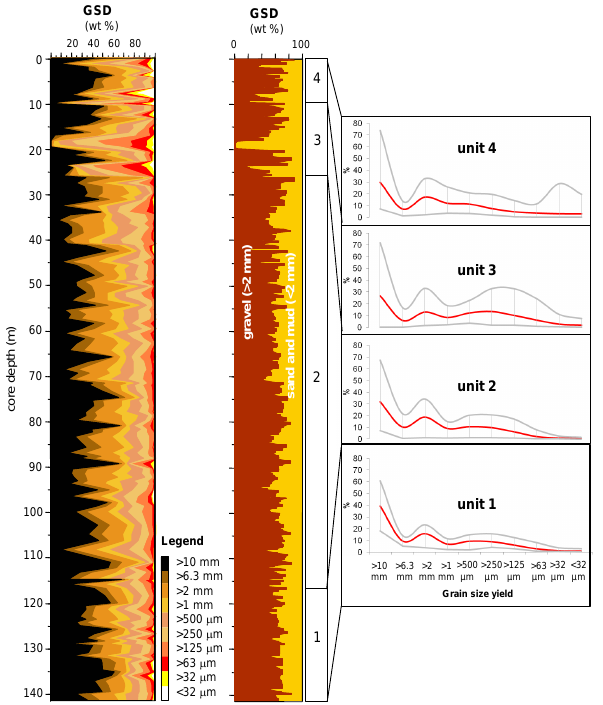
Fig. 6. Grain size distribution (GSD) and gravel/sand+mud boundary for core 5011-3, and modal grain size composition in units 1 to 4 (red line = mean, upper grey line = maximum, lower grey line = minimum).